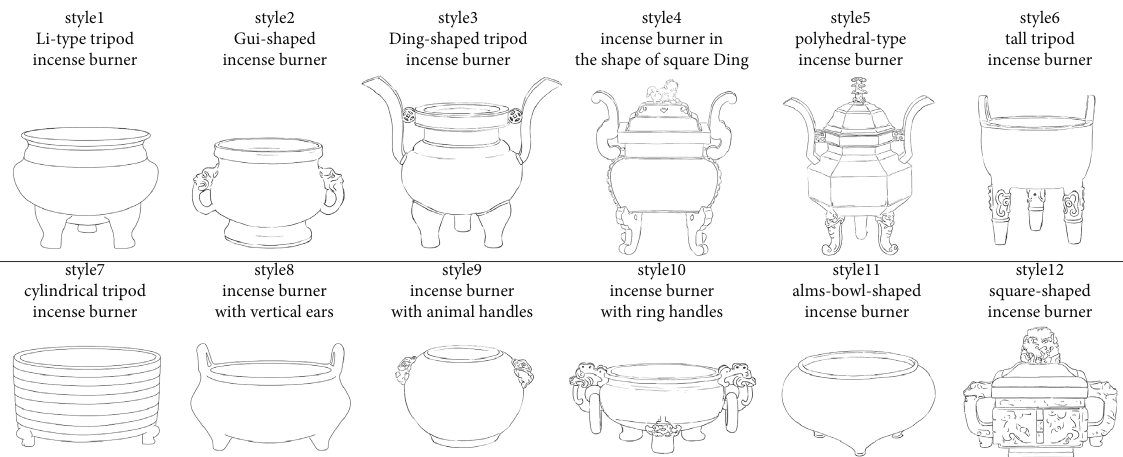
Figure 1: Incense burner style in the Ming and Qing dynasties.